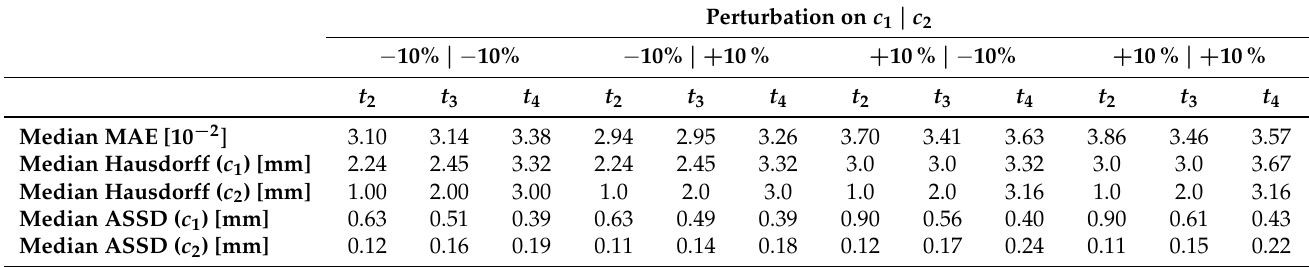
Table 5. Median values of the voxelwise mean absolute error (MAE) between the true and estimated cell-density distributions within the c > 0.01 contour as well as of the Hausdorff distance and average symmetric surface distance (ASSD) between the true and estimated imaging contours for threshold values of c 1 = 0.80 and c 2 = 0.16 computed over the test set for times t 2 , t 3 , and t 4 . The predicted cell-density estimations and parameter values used for the calculations were obtained for all combinations of ± 10% perturbations on the c 1 and c 2 threshold values used to generate the input contours Γ 1 , Γ 2 , and Γ 3 of both networks.